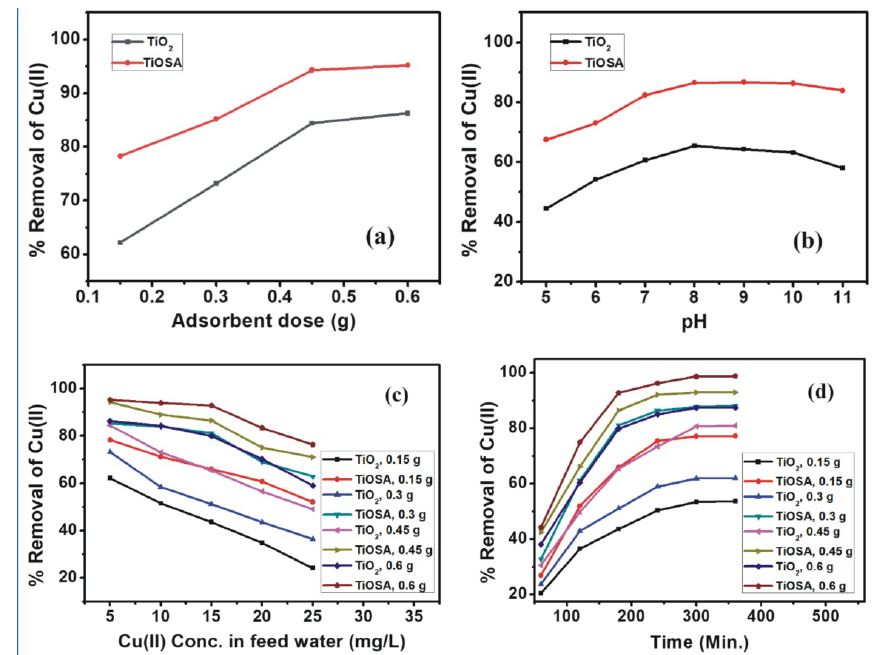
Fig. 2. (a) Effect of adsorbent dose on % removal of Cu (II), (b) Effect of pH on % removal of Cu (II), (c) Effect of initial ion concentra- tion on % removal of Cu (II), and (d) Effect of contact time on % removal of Cu